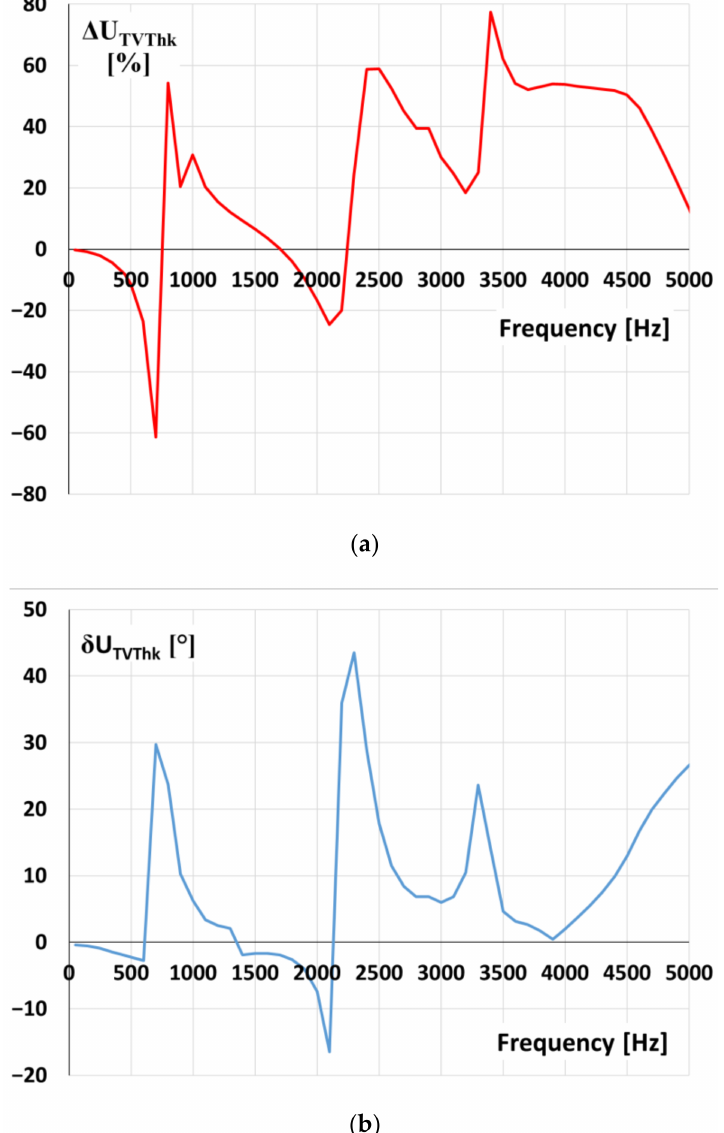
Figure 13. The values of the ( a ) voltage error and ( b ) phase displacement at harmonics of the 15 kV voltage